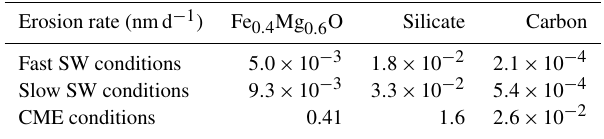
Figure 6. Sputtering lifetimes for 1nm dust for the three different solar wind conditions (blue – CME conditions, red – fast solar wind, green – slow solar wind) as a function of distance from the Sun; line styles indicate the dust compositions (Fe 0 . 4 Mg 0 . 6 O – dotted, silicate – solid, carbon – dashed). Table 2. Dust erosion rate for the three compositions and solar wind conditions. Rates are given for 0.1AU, and the erosion rate is inde- pendent of dust size and decreases quadratically with distance from the Sun.